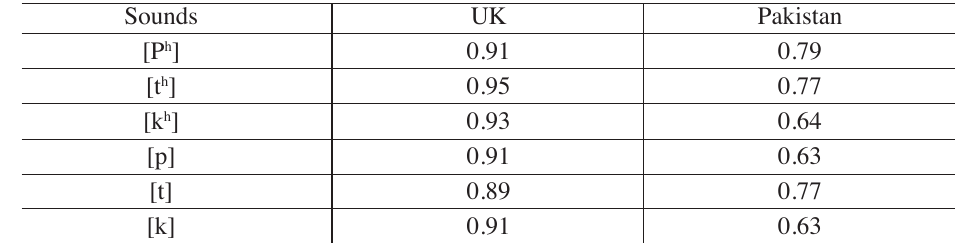
Table 1: Cronbach’s alpha values for consistency in